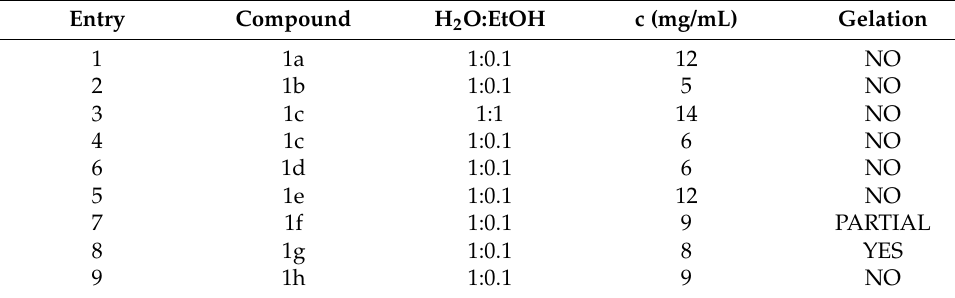
Table 1. Gelation test under microwave irradiation of dicarbonyl compounds 1a–h .